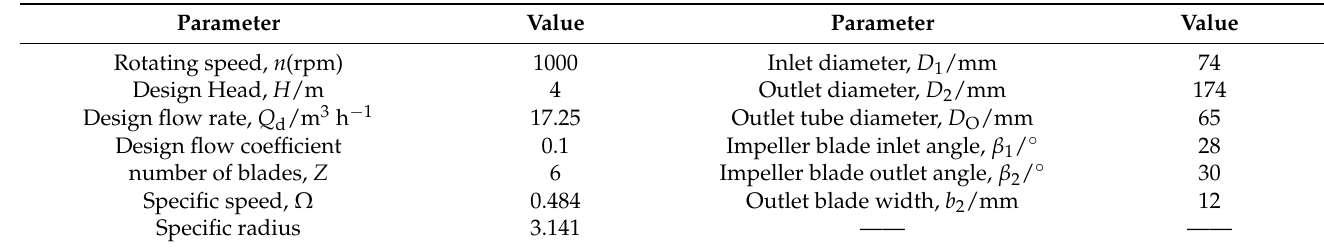
Figure 2. Test rig.